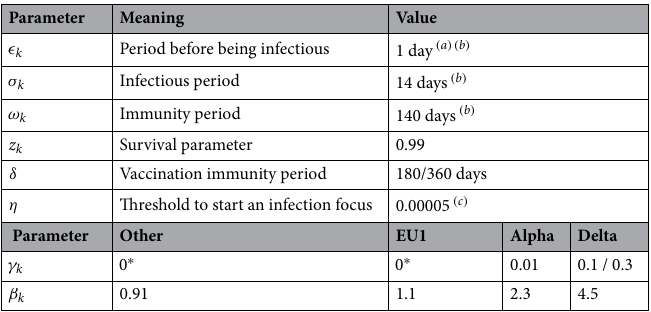
Table 1. Model parameters. The upper panel includes epidemiological parameters common to all strains. The a lower panel shows the parameters that differ among strains. This value was set to 0 for the Delta variant in b c order to get a better fit. Values fitted and used with this model in previous works 17–19 . Corresponds to start of an infection focus with 1 infected persn in an averagely populated area. ∗ Values left as zero for simplicity, considering that when massive immunization began, Alpha was the dominant